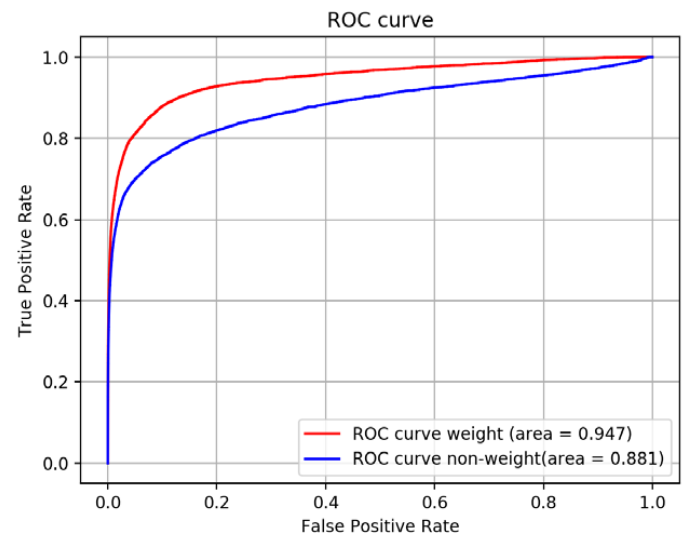
Figure 6. The receiver operating characteristic (ROC) curve of the weighted loss model compared with that of the non-weighted loss model.